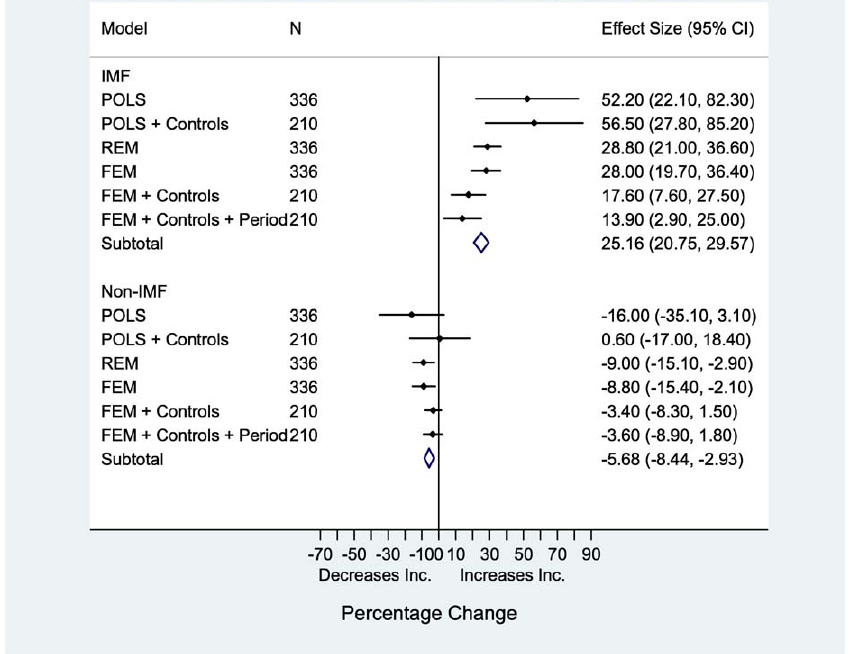
Figure 2. Forest Plot: Effects of IMF and Non-IMF Debt on Log Tuberculosis Incidence Results Plot is based on six separate regression models using various controls and functional forms. Weighting used for aggregation calculated based on confidence intervals provided in STATA’s standard metan module. Controls include either IMF or non-IMF program, change in log GDP, level of log GDP per capita, democratization index, dummy for occurrence of military or ethnic conflict, population dependency ratios, percentage of the population with tertiary education, and urbanization rates. CI, 95% confidence interval; FEM, fixed effects model, which uses a set of country dummies; POLS, pooled OLS model; REM, random effects model. ‘‘ Period ’’ refers to a set of year dummies.